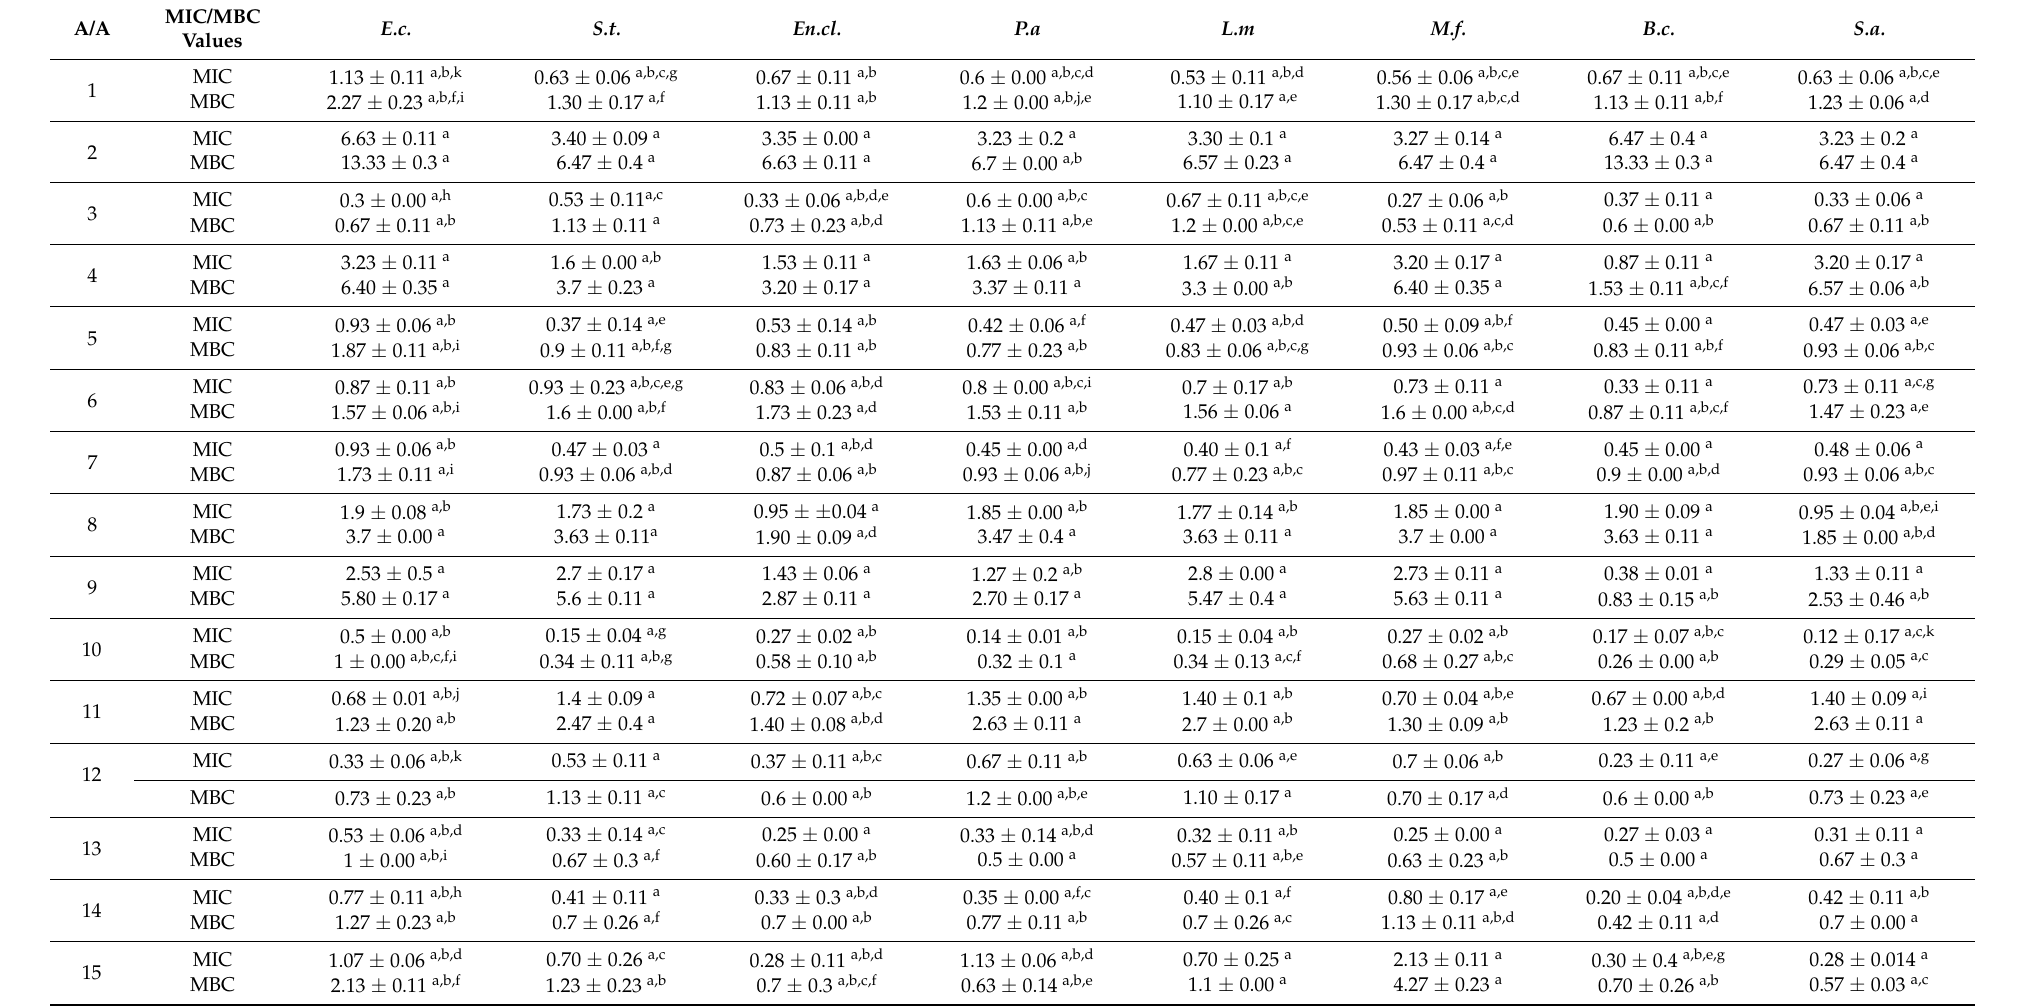
Table 5. Antibacterial activity of wine lees sediment against ATCC bacteria (mg mL − 1